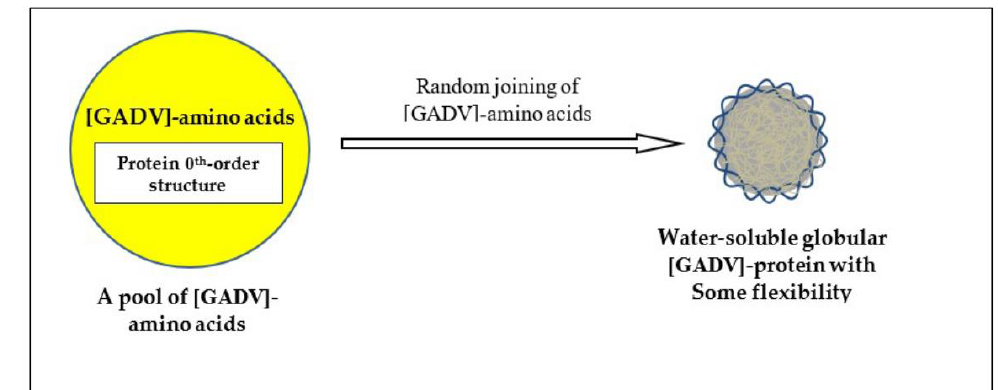
Figure 4. One of protein 0th-order structures or [GADV]-amino acid composition, which is the key concept of GADV hypothesis. Immature but water-soluble globular [GADV]-proteins, which were actually [GADV]-peptide aggregates, could be produced even by the joining of [GADV]-amino acids, which were randomly selected out from a pool containing [GADV]-amino acids at roughly equal amounts [16].